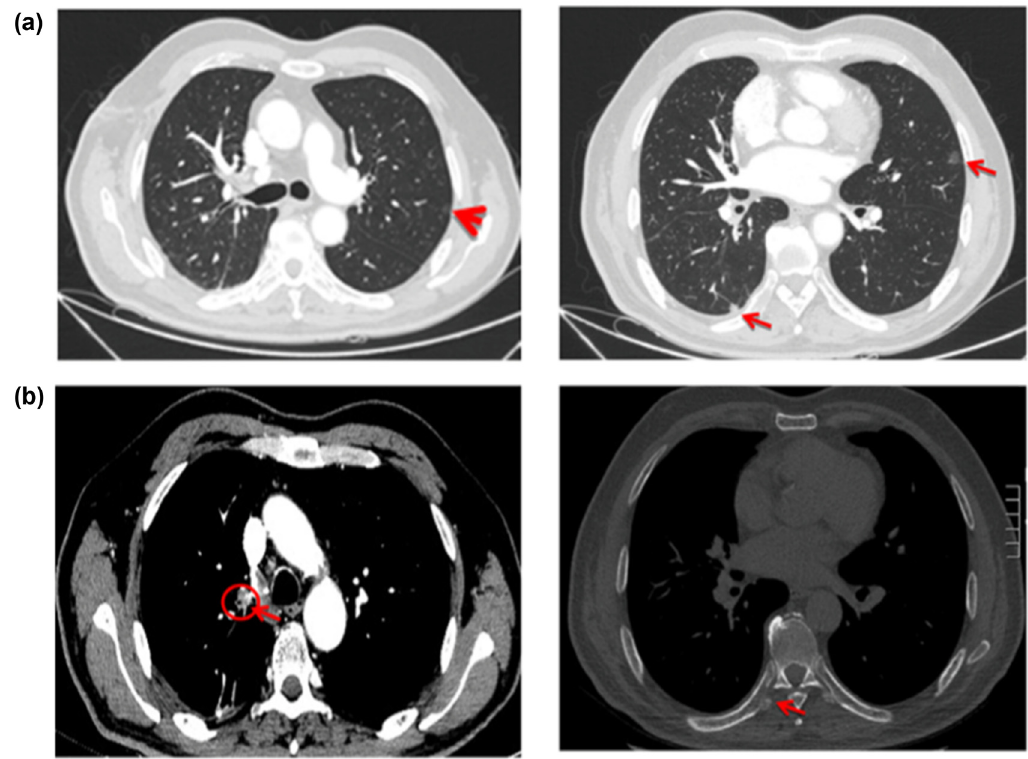
Figure 2: ( a and b ) Baseline CT of the pretreatment primary tumor lesions ( July 17, 2017 )